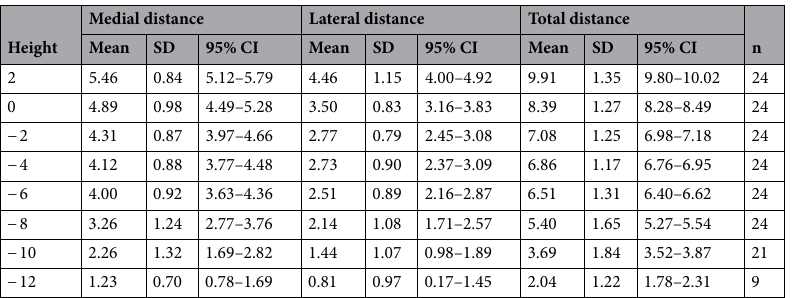
Table A-8. All p-values are given in supplemental Table B-2. Three of the four subregions of the first metatarsal averaged positive Gaussian curvature, but all subregions of the second metatarsal averaged slightly negative curvature measure. The dorsal-lateral and plantar-lateral regions of the first metatarsal had significantly convex curvature (p = 0.009) and the dorsal-medial region of the second metatarsal had significantly concave curvature (p < 0.001). All other regions of the metatarsals were not significantly curved. Three-way ANOVA in the medial cuneiform showed significant differences in curvature between region (p = 0.033) and specimen (p < 0.001), but not between sides. Games-Howell post-hoc analysis revealed that the dorsal-medial region had significantly more convex curvature than either the plantar-medial or plantar-lateral region (p = 0.035). However, three-way ANOVA with post-hoc analysis revealed no significant differences in curvature between subregions in any of the other articular surfaces. All p-values are given in supplemental Table B-4. In the whole joint and in each of the four subregions in each TMT joint, the average curvature similarity values were negative. This summary data is presented in Table 4, and all raw data is given in supplemental Tables A-9 and A-10. Both the first and second TMT joints, as well as all four regions of each joint, showed curvature similarity values significantly different from 1 (p < 0.001) and from negative 1 (p = 0.001), showing a significant difference from matched or anti-matched surfaces. All p-values are given in supplemental Table B-5. Both whole joints showed curvature similarity significantly less than zero (p = 0.003). Each region of the first TMT joint except the plantar-medial showed curvature similarity significantly less than zero (p = 0.001), and the two plantar regions of the second TMT joint shoed curvature similarity significantly less than zero (p = 0.045). Three-way ANOVA showed no significant difference in curvature similarity between the first and second TMT joints or between subregions within either joint. Games-Howell post-hoc analysis showed that the plantar-lateral